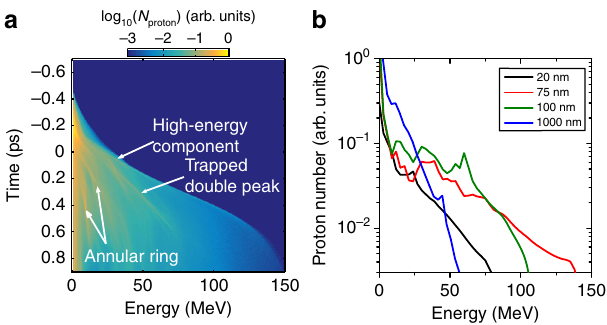
Fig. 8 Energy spectra from the simulation results. a Temporal evolution of the proton energy spectrum for a ‘ = 75 nm target, sampled within an angular cone of ±60° of the laser axis. Distinct proton energy components are labelled. b Proton energy spectrum at t = 0.8 ps for given foil